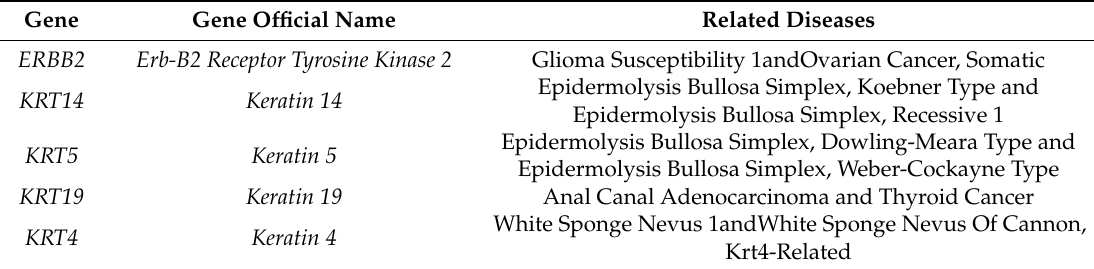
Table 7. The top five genes selected by LJELSR for the ESCA